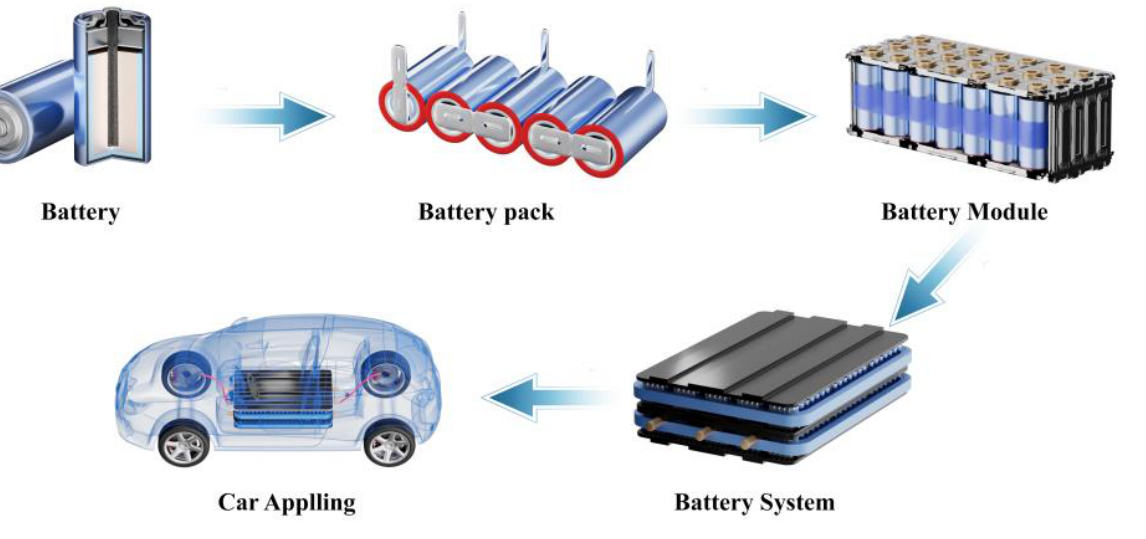
Figure 2. Application of lithium batteries on different scales.